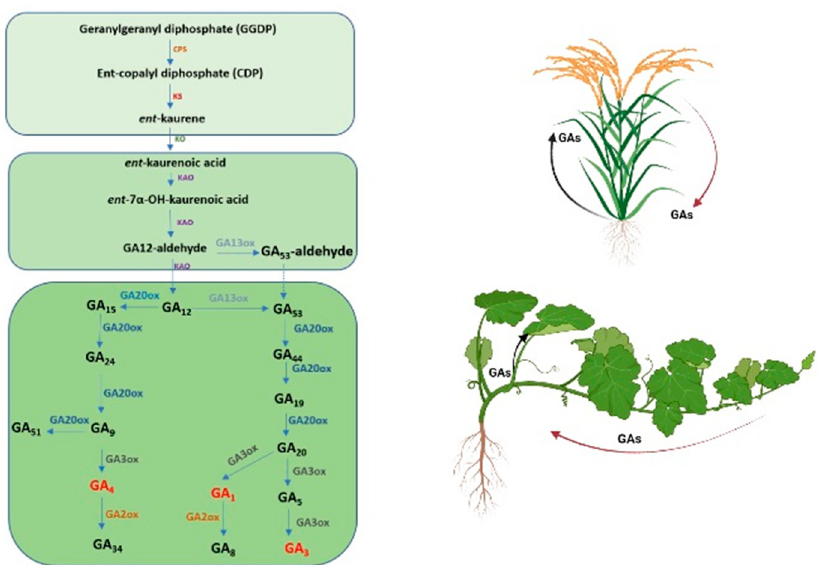
Figure 1. GA biosynthesis and endogenous bioactive GA levels in plants. Illustration of a schematic plant ( right ) and GA biosynthesis ( left ). The arrows are color-coded to correlate with GA forms shown in the biosynthetic pathway. Red arrows indicate the reduced level of GAs due to plant organ position, while black arrows indicate the increased level of GAs. In several plants, such as rice and watermelons, GA content is high at the base of the leaf or lower side [10,35] . In addition, several reports also found that bioactive GA content was reduced following the large length of the base to leaves [28] . In these cases, the exact level of GAs was not clear.